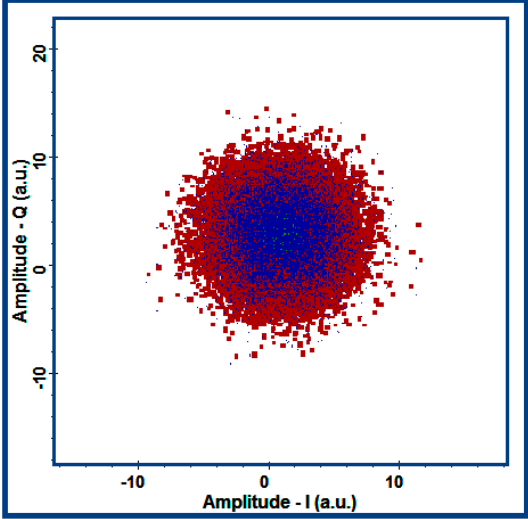
Figure 13. Constellation of the filtered 4QAM-OFDM signal in the MT.